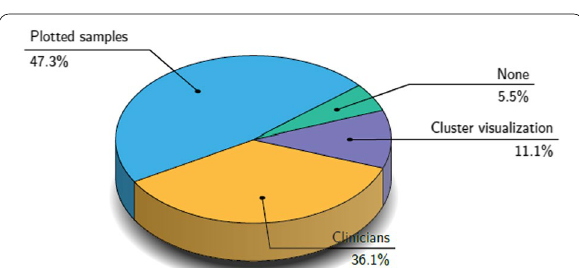
Fig. 11 Qualitative methods were used in the examined studies for evaluating the generated samples. Almost half of the examined studies evaluated the synthetic images by visualization, whereas 36.1% employed expert clinicians to assess the generated samples using statistical methods or an operator-assisted device that produces a stochastic sequence of binary questions from a given test image (i.e., Visual Turing Test). The 11.1% used cluster visualization methods such as PCA and t-SNE, and a small percentage (5.5%) did not use any qualitative method to assess the synthetic